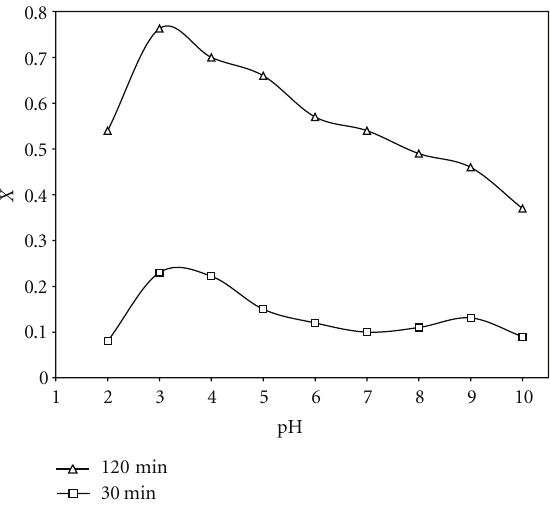
Figure 2: E ff ect of pH on degradation of wastewater at two typical irradiation times: [TiO 2 ] = 100 mg · L − 1 and T = 20 ◦ C.